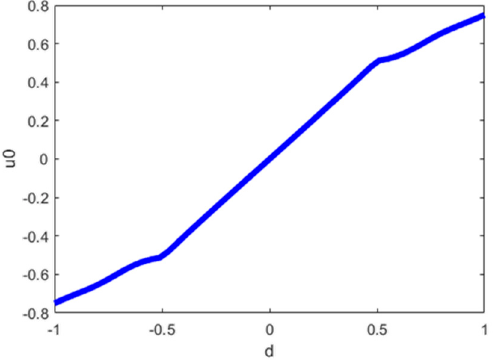
Figure 7. SIFLC control surface.